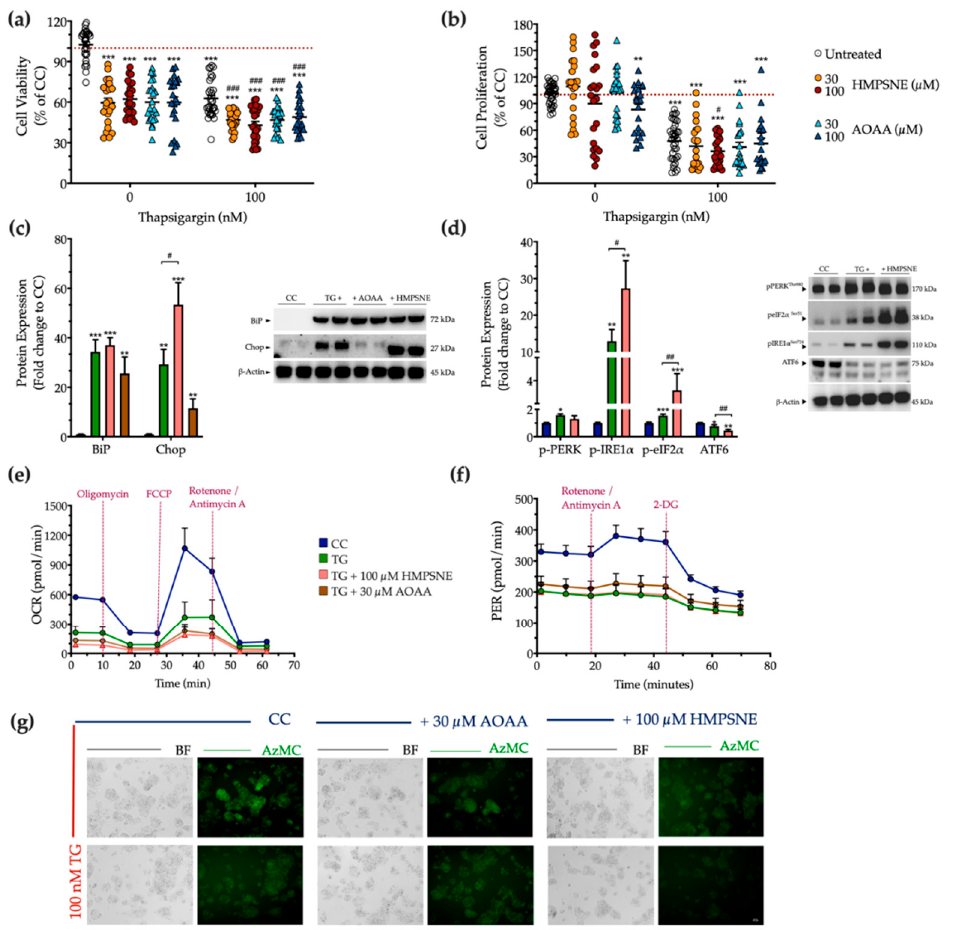
Figure 11. 3-MST pharmacological inhibition strengthens UPR apoptotic signals to exacerbate cell growth arrest under condition of persistent ER stress. HepG2 cells were serum-starved for 8 h and treated with the vehicle or 100 nM of thapsigargin (TG), in the presence or absence of HMPSNE or AOAA for 16 h. Micro-cultures were assayed for XTT conversion ( a ) and BrdU incorporation ( b ) to assess cell viability and proliferation, respectively. Moreover, cells were harvested and processed for protein expression of the UPR sensors–BiP ( c ), IRE1 α (activating phosphorylation at Ser724), PERK (activating phosphorylation at Thr 980), eIF2 α (inhibitory phosphorylation at Ser51), and total ATF6 ( d ), along with the UPR apoptotic mediator–Chop ( c ). We also monitored the oxygen consumption rate (OCR) over the sequential injection of oligomycin (1 µ M; ATP synthase inhibitor), FCCP (1.5 µ M; mitochondrial uncoupler) and of rotenone + antimycin A (0.5 µ M; Complex I and III inhibitors) ( e ) and the proton e ffl ux rate (PER) over the sequential injection of rotenone + antimycin A and 2-deoxy-D-glucose (20 mM) ( f ) with the Seahorse XFe24 Extracellular Flux Analyzer for assessing glycolysis and oxidative phosphorylation, respectively. Representative pictures of the AzMC signal were captured with an Olympus CKX53 inverted microscope at 10 × magnification; the left sub-panel corresponds to the bright-field channel (BF) for whole-cell imaging, while the right sub-panel to the DAPI fluorescent channel for AzMC imaging ( g ). Each graph line and bar represent mean ± SEM from three independent experiments. Data are expressed as a percentage or fold change of the control (vehicle-treated) conditions (CC). * p ≤ 0.05, ** p ≤ 0.01 and *** p ≤ 0.001 compared to corresponding CC; # p ≤ 0.05, ## p ≤ 0.01 and ### p ≤ 0.001 compared to the corresponding TG-treated